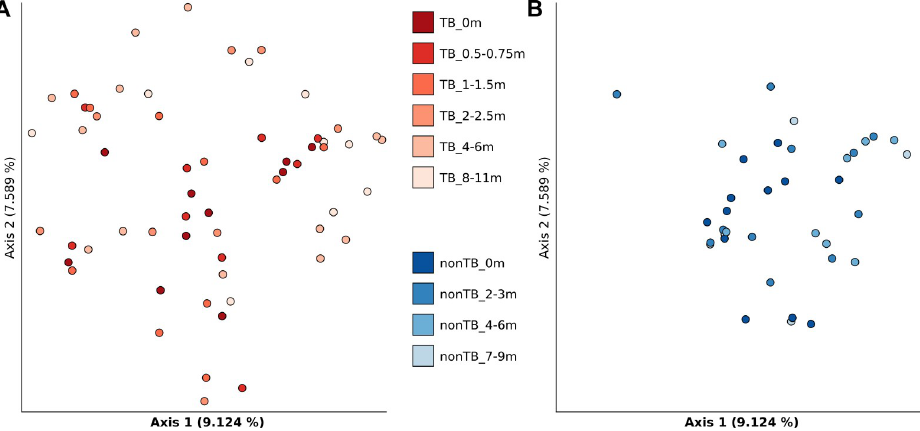
Fig 4. Principal component analysis (PCoA) of the sputum samples collected in Italy, based on Bray-Curtis distances. A. Samples collected from tuberculosis (TB) patients. The different colors indicate the various time-points. B. Samples collected from pneumonia (nonTB) patients. The different colors correspond to the various